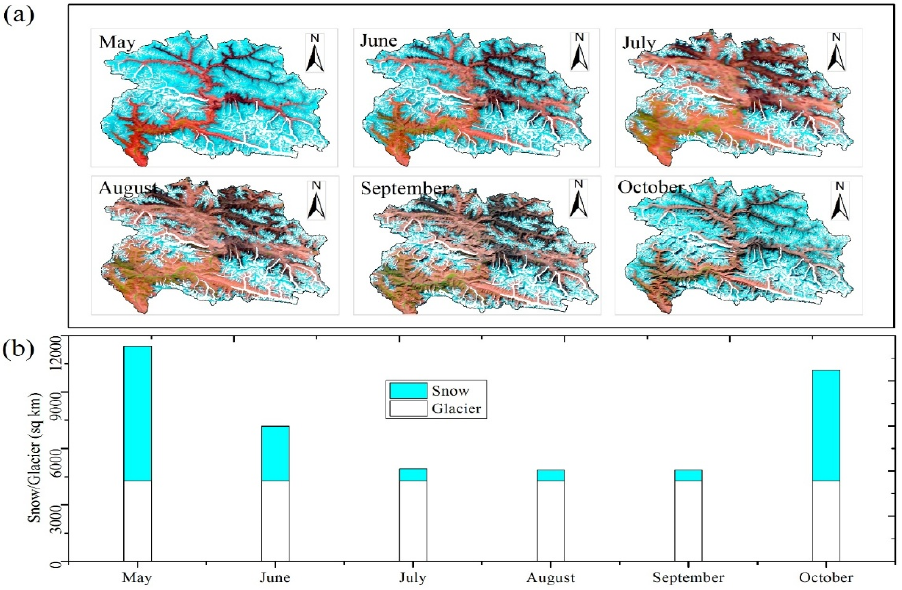
Figure 4. ( a ) Monthly images acquired by MODIS sensors on the Terra and Aqua satellites, superim- posed with glacier outlines. ( b ) Monthly snow cover (derived from satellite data shown in cyan color) variations vs. glacier cover shown in white (RGI 6.0) within the Hunza